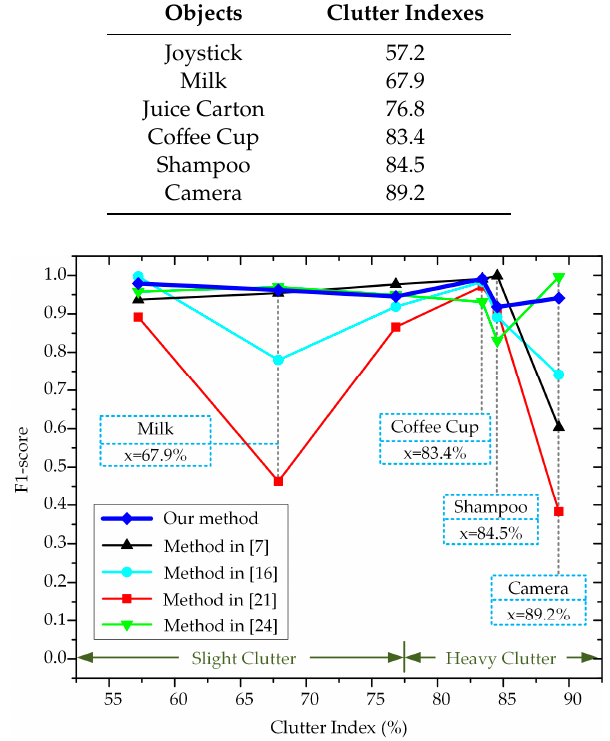
Figure 10. F1-scores against different levels of background clutter.